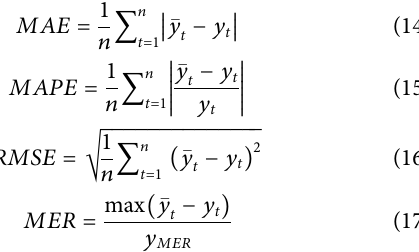
Table 1 . The interval prediction in this study is divided into